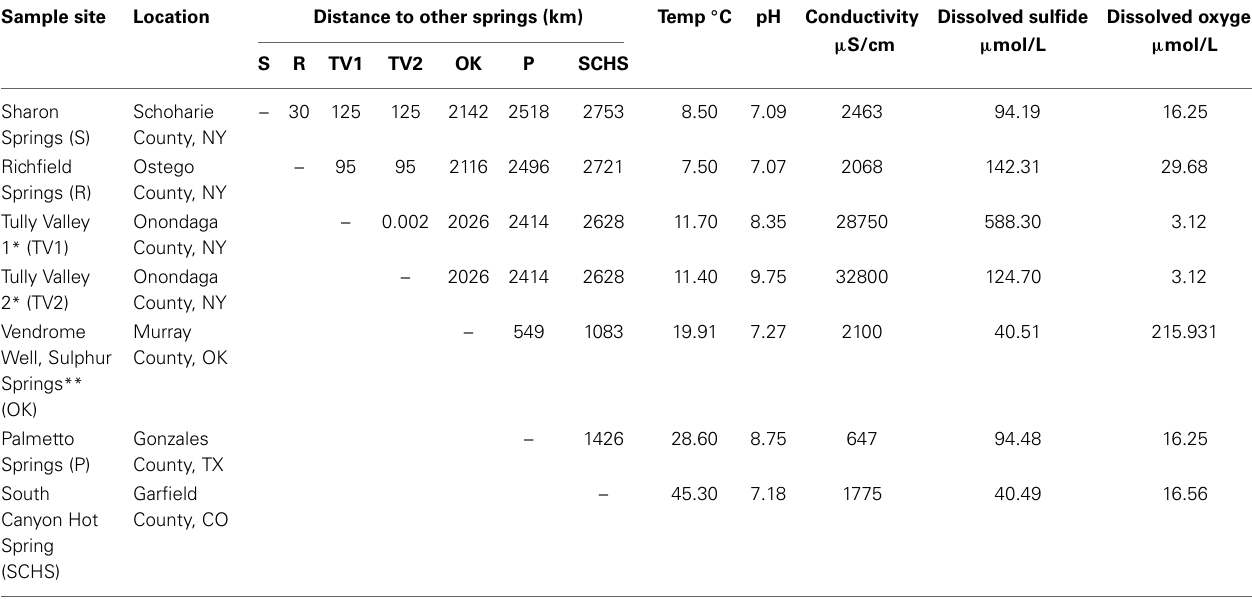
Table 1 | Geographic and geochemical details from springs sampled in this